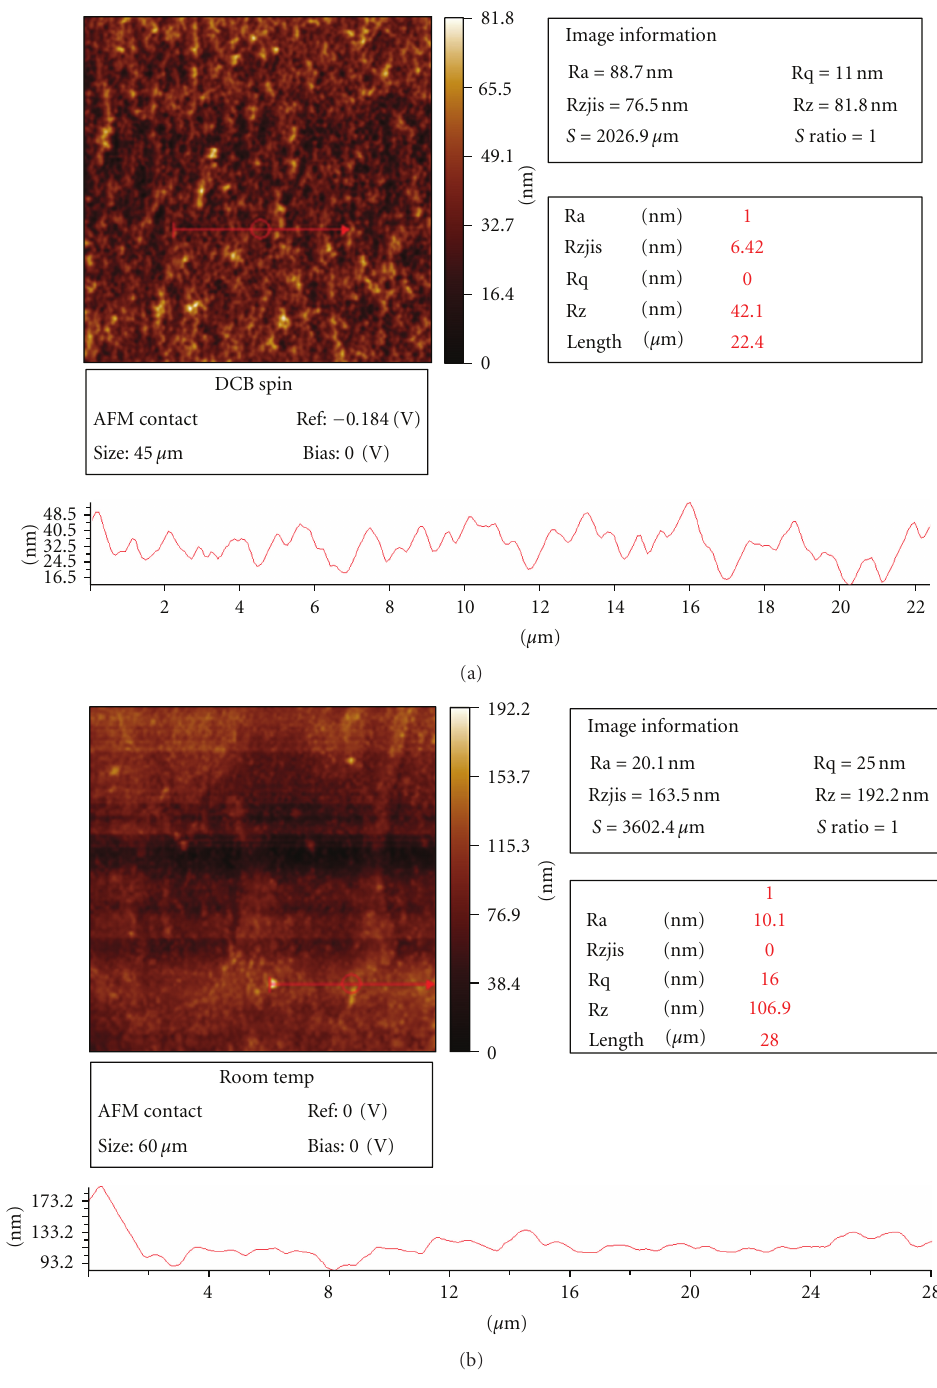
Figure 5: AFM topology analysis of (a) a spun-casted film and (b) a spray-casted film using DCB as carrier solvent.